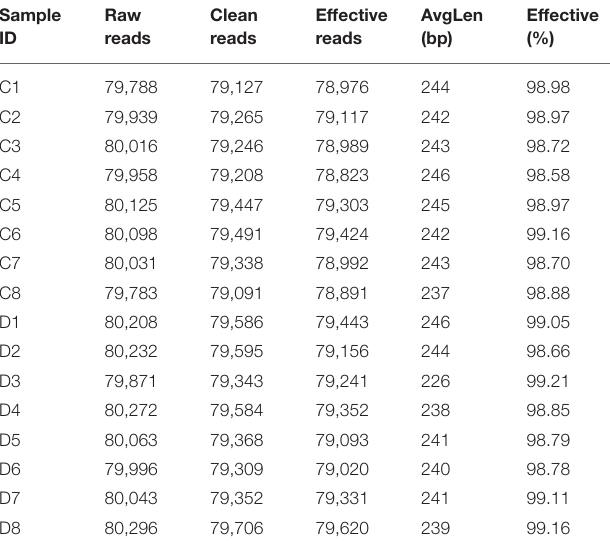
TABLE 1 | The sequencing data processing results of fecal samples. Sample